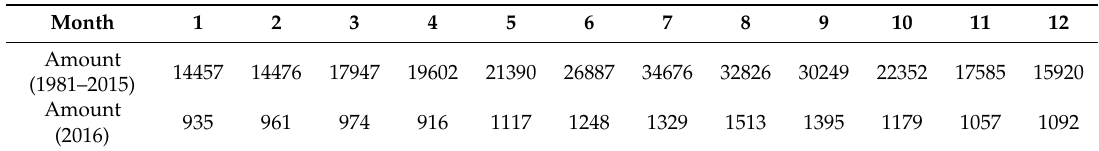
Table 2. Amount of ICOADS data, including atmosphere visibility, SLP, AT, RH, SST and WS for